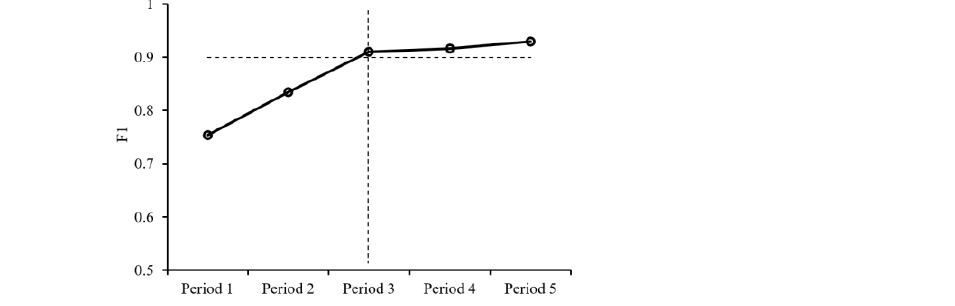
Figure 5. Variations in F1 of garlic. “ Period 1 ” , “ Period 2 ” , “ Period 3 ” , “ Period 4 ” , and “ Period 5 ” represent the germination period, seedling period, bud differentiation period, elongation period, and expansion period, respectively.